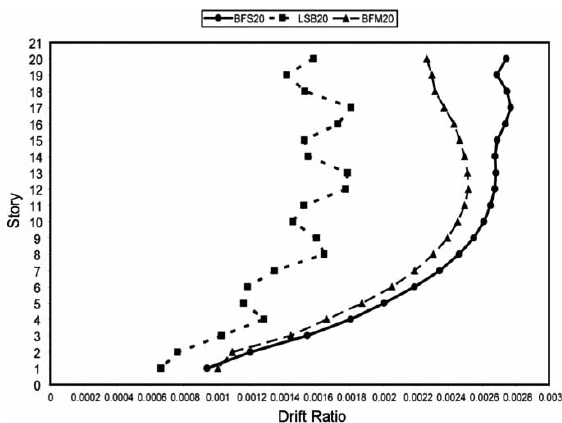
Fig. 16. Drift ratio of different